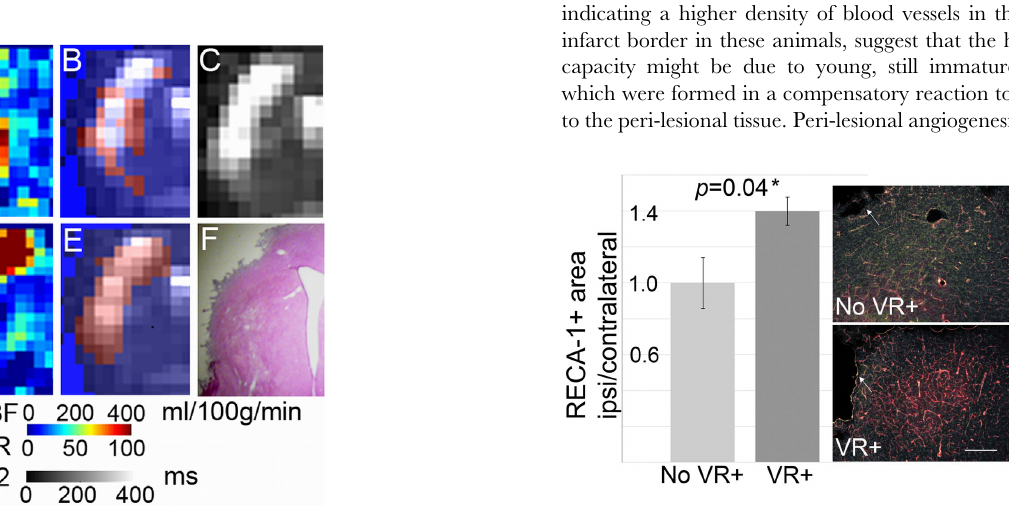
Figure 5. Distribution of voxels with increased d14 vasoreac- tivity. (A) Infarct region of one animal on d14 - CBF map with hyperperfused voxels (B, shown in red) overlaid onto the d14 - T2 map (B and C). These voxels were localized to the infarct border. (D) Day 14 – vasoreactivity (VR) map. Voxels with increased vasoreactivity are shown in red and overlaid on the T2 map: E. Hematoxylin-eosin stained section of the corresponding region in F.